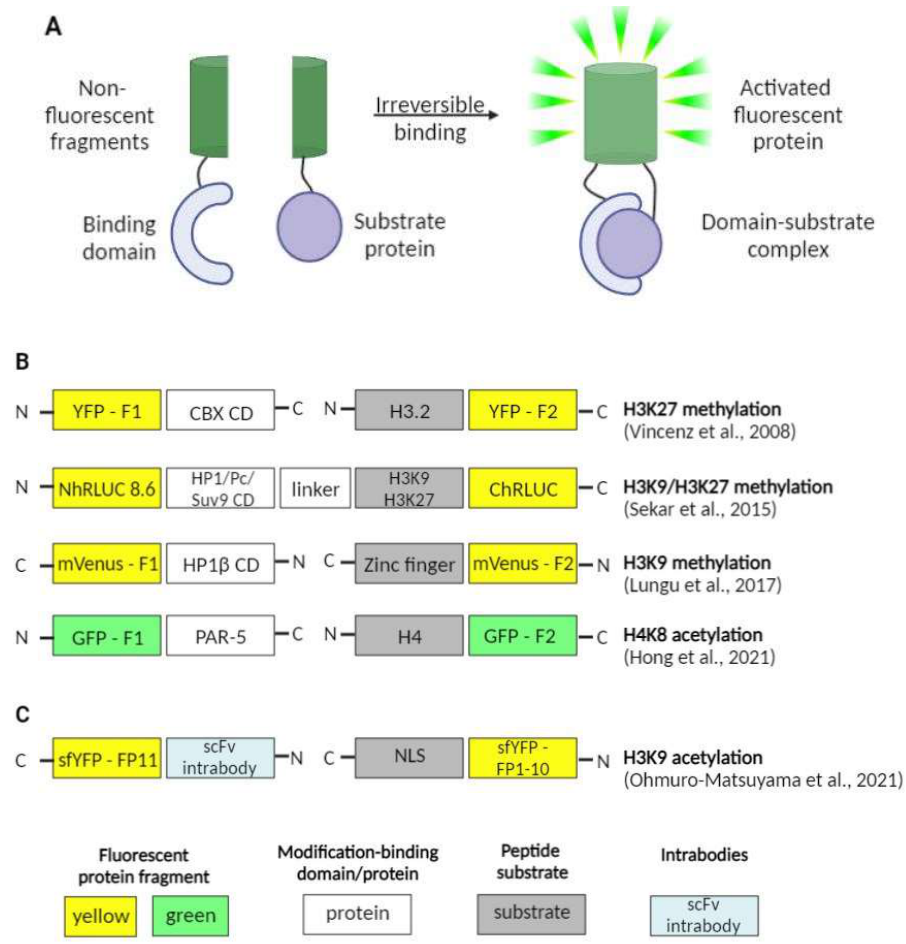
Figure 4. BiFC sensors for live-cell imaging. ( A ) General design of BiFC sensors. ( B , C ) Domain structures of FP-based and scFv-based BiFC sensors, respectively [49,53,54,58,63].